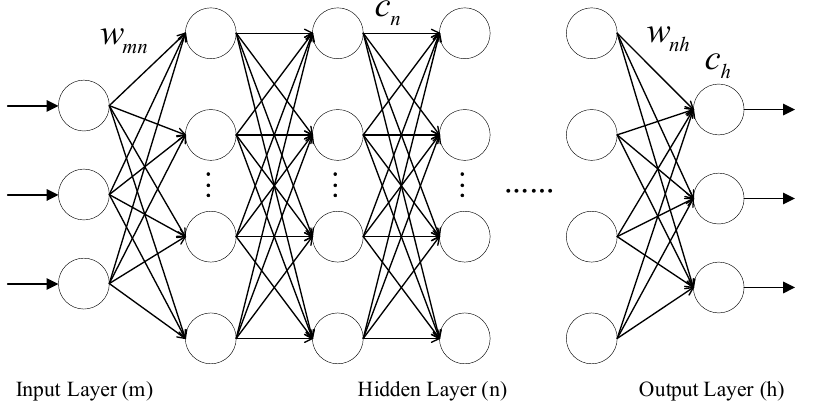
Figure 2. The topological structure of the DFNN algorithm.